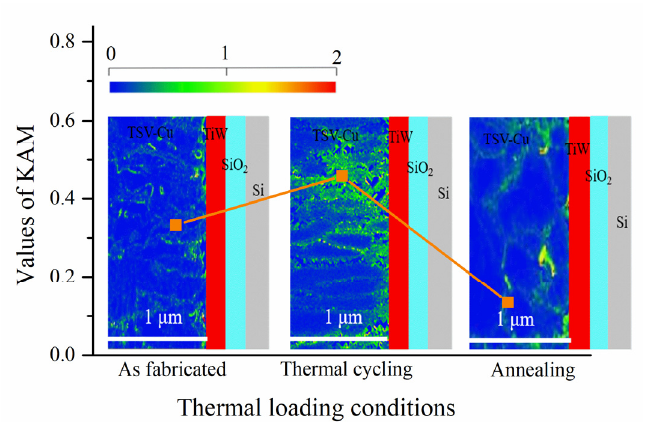
Figure 9. The local misorientation distribution of TSV-Cu under different thermal loading